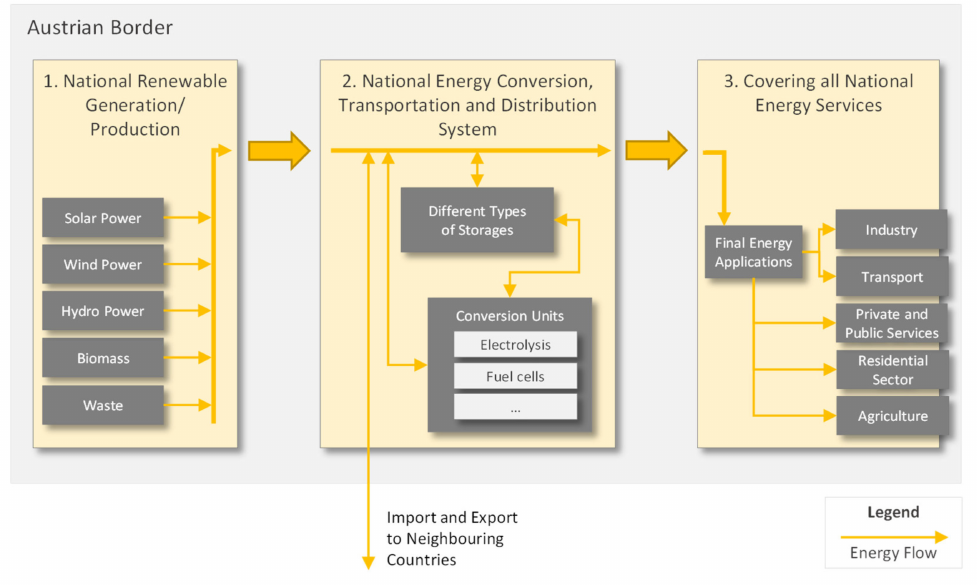
Figure 2. System boundaries of the Austrian energy system